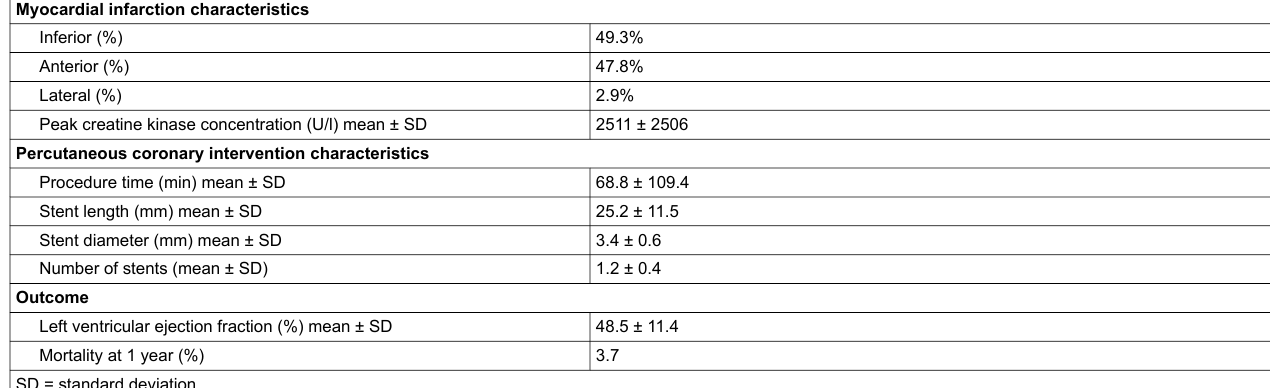
Table 2: Myocardial infarction and percutaneous intervention characteristics, and outcomes (n = 222). Myocardial infarction